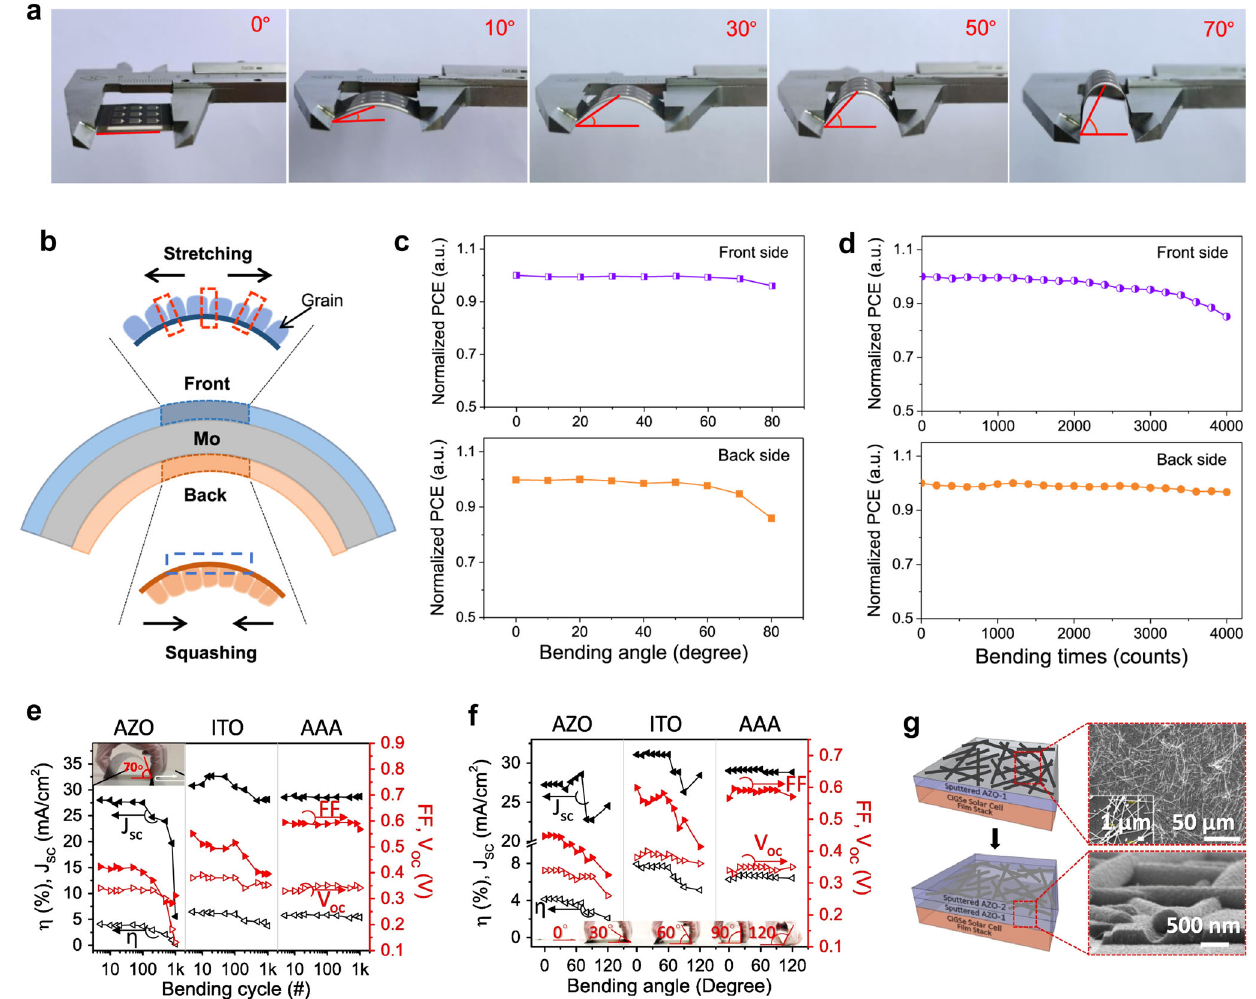
Fig. 6 Flexibility of CZTSSe thin- fi lm solar cells. a Photographs of bended bifacial CZTSSe solar cells fabricated on Mo foils at varied angles from 0° to 70°. b Schematic bending states with stretching and squashing of front (convex) and back (concave) sides. c Normalized PCE degradation percent of bifacial solar cells at different angles (0° – 80°) with 100 time bending. d Normalized PCE degradation evolution with different bending cycles (0 – 4000 times) at a fi xed angle of 50°. Reproduced with permission 72 . e , f The bending test of AZO, ITO and AZO/Ag nano-wires/AZO (AAA) electrodes on fl exible CIGS solar cells e with 1000 cycles and f different bending angles. g The schemes of fabrication of AAA transparent conductive electrodes. The insets show the top-view images of Ag nanowires on the 1st layer of AZO thin fi lm and cross- section view image of AAA electrodes. Reproduced with permission 83 . Copyright 2019, Elsevier B.V. All rights reserved.